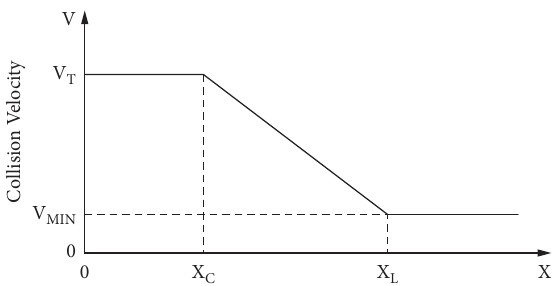
Figure 2: Distribution map of vessel collision velocity. V : design collision velocity; V T : typical navigation velocity of vessels in channel; V : minimum collision velocity (no less than annual MIN mean value of current velocity); x : distance between vessel and pier; x c : distance between vessel and channel edge; LOA from the channel center